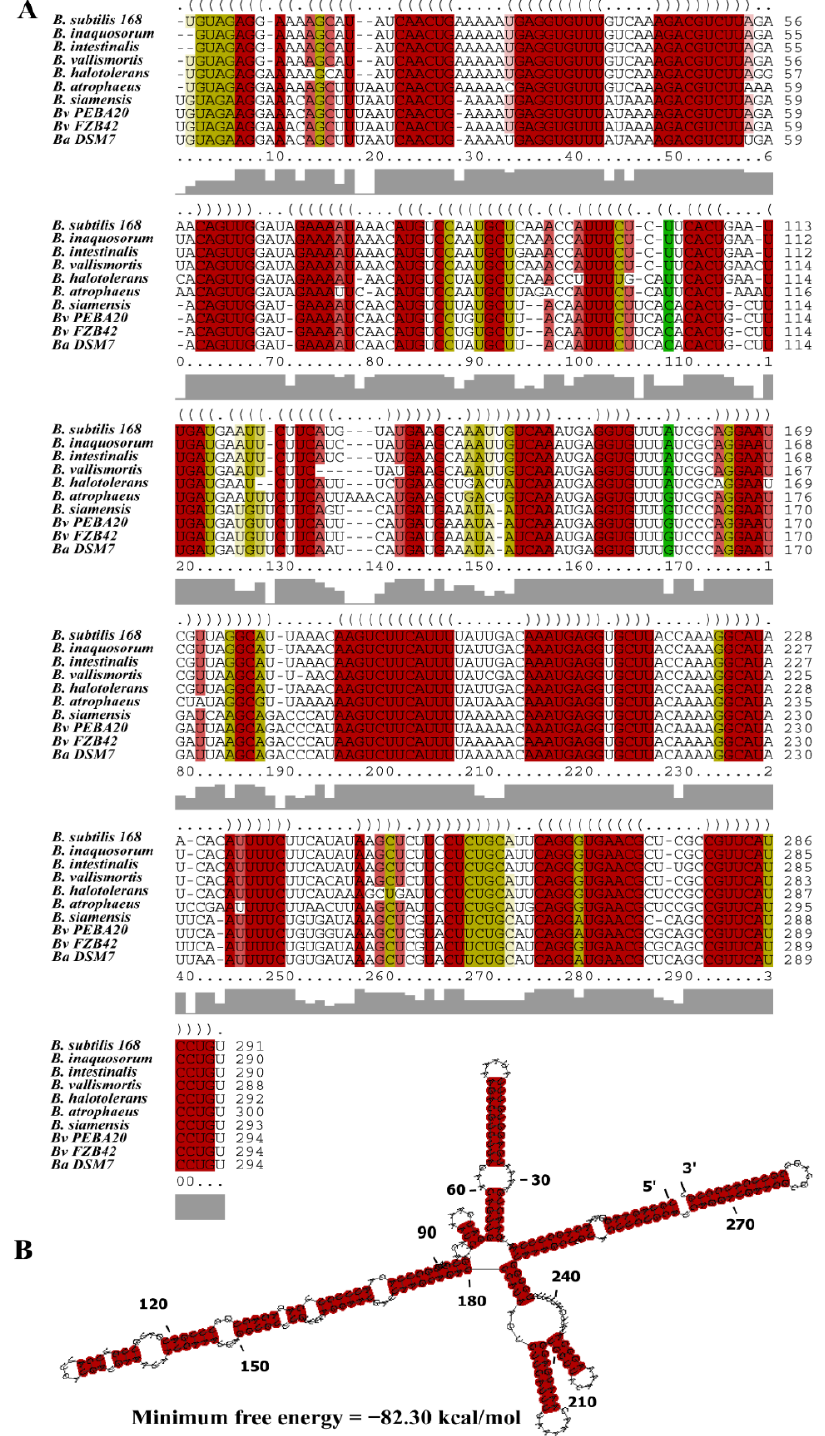
Figure 2. The conservative sequence and secondary structure of bvs196 . ( A ) LocARNA tool was used to conduct multiple sequence alignment of 10 bvs196 orthologs. The structural conservation is shown as the different colors: red indicates 100% identical and brown and green indicate one or two nucleotides changed, separately. Bv represents B. velezensis and Ba represents B. amyloliquefaciens . ( B ) Secondary structure was predicted by RNAalifold, and the minimum free energy value is shown.